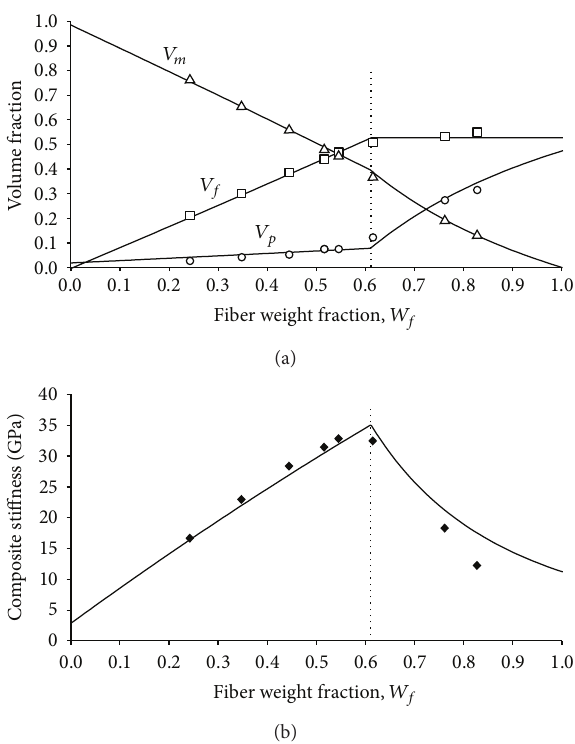
Figure 7: Experimental data and model predictions of (a) volumet- ric composition ( 𝑉 𝑓 , 𝑉 𝑚 , and 𝑉 𝑝 ) and (b) stiffness as a function of the fiber weight fraction of unidirectional flax fiber/polyethylene terephthalate composites. Vertical dotted lines indicate the transi- tion fiber weight fraction. Data from